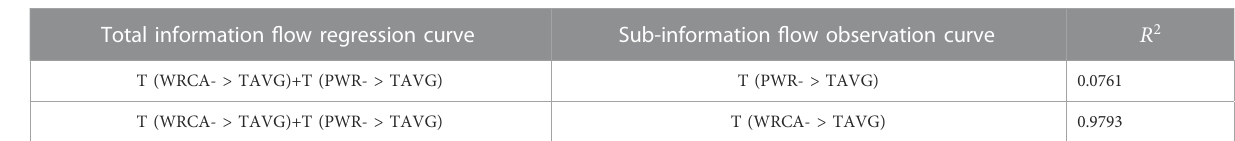
TABLE 4 Goodness of fi t table of 200s of 5% LOCA fault information fl